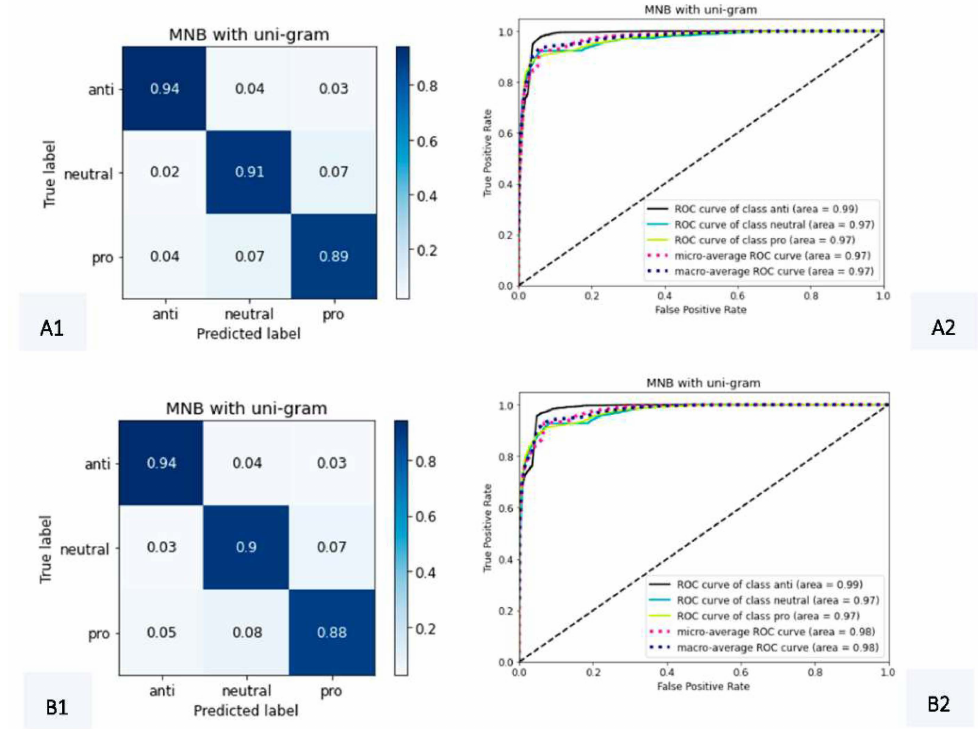
Figure 6. Confusion matrices and ROC curves for MNB with count ( A1 , A2 ) and TF–IDF ( B1 , B2 ) vectorizers, using